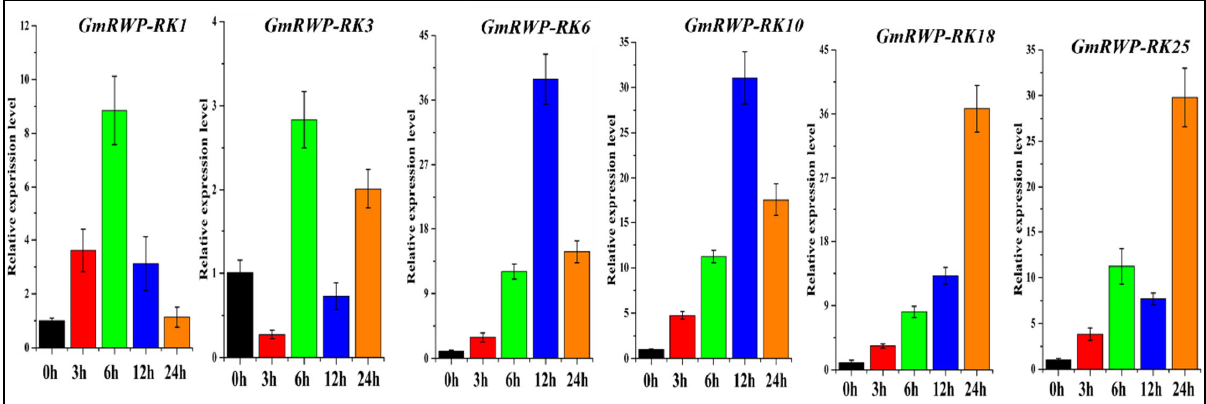
Figure 9. Relative expression level of GmRWP-RK genes in response to heat stress at different time points using qRT-PCR analysis. The different colored bars represent different time periods from (0–24 h). Error bars show the ±SE from three independent biological replicates.